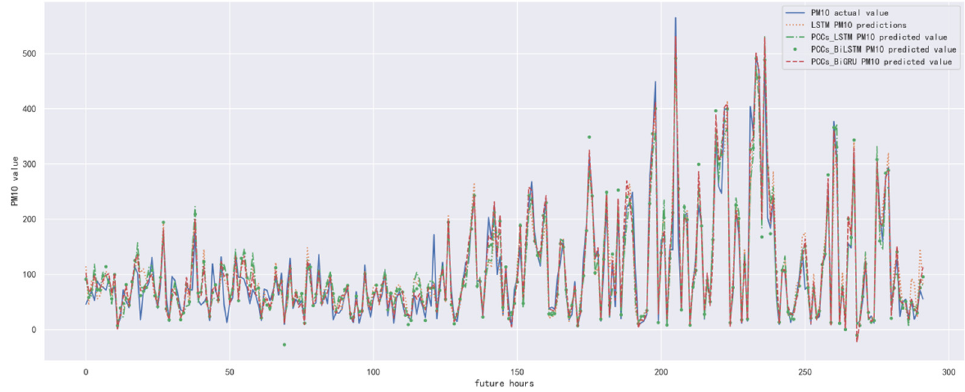
Figure 16. The schematic diagram of predicted PM 10 concentration in the next one hour.